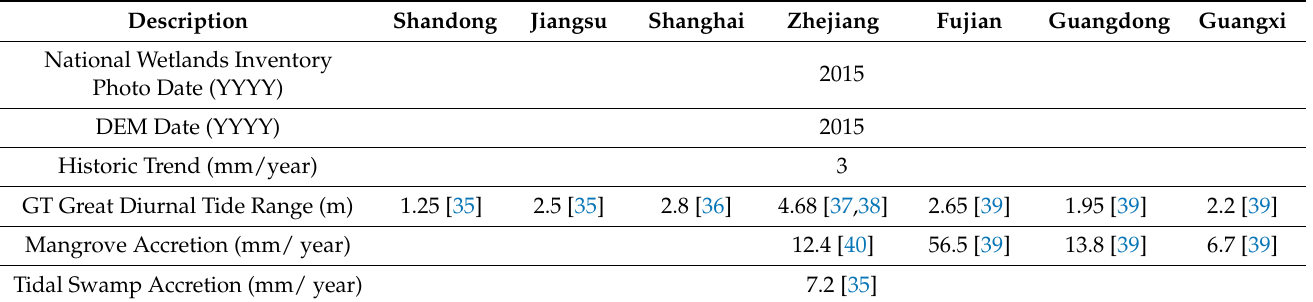
Table 2. Input parameters required for SLAMM.